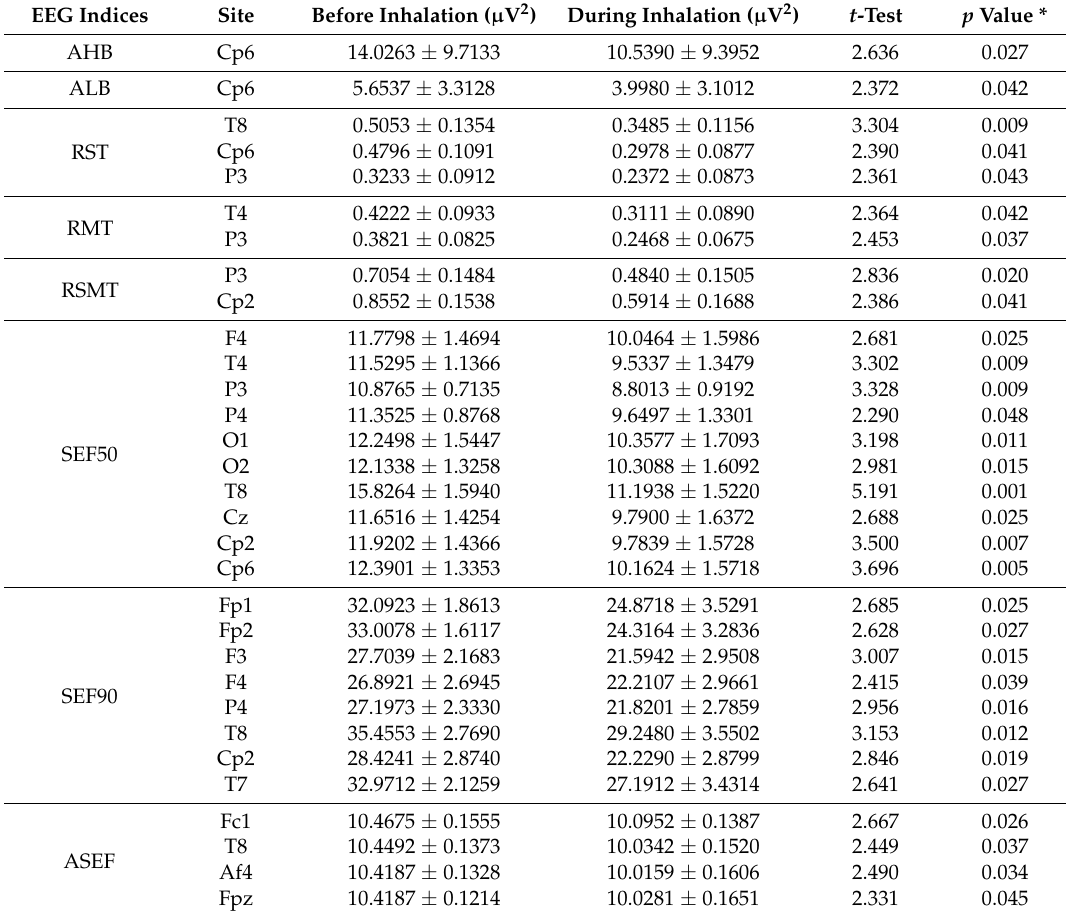
Table 2. Significant changes of EEG power spectra during the inhalation of geosmin in